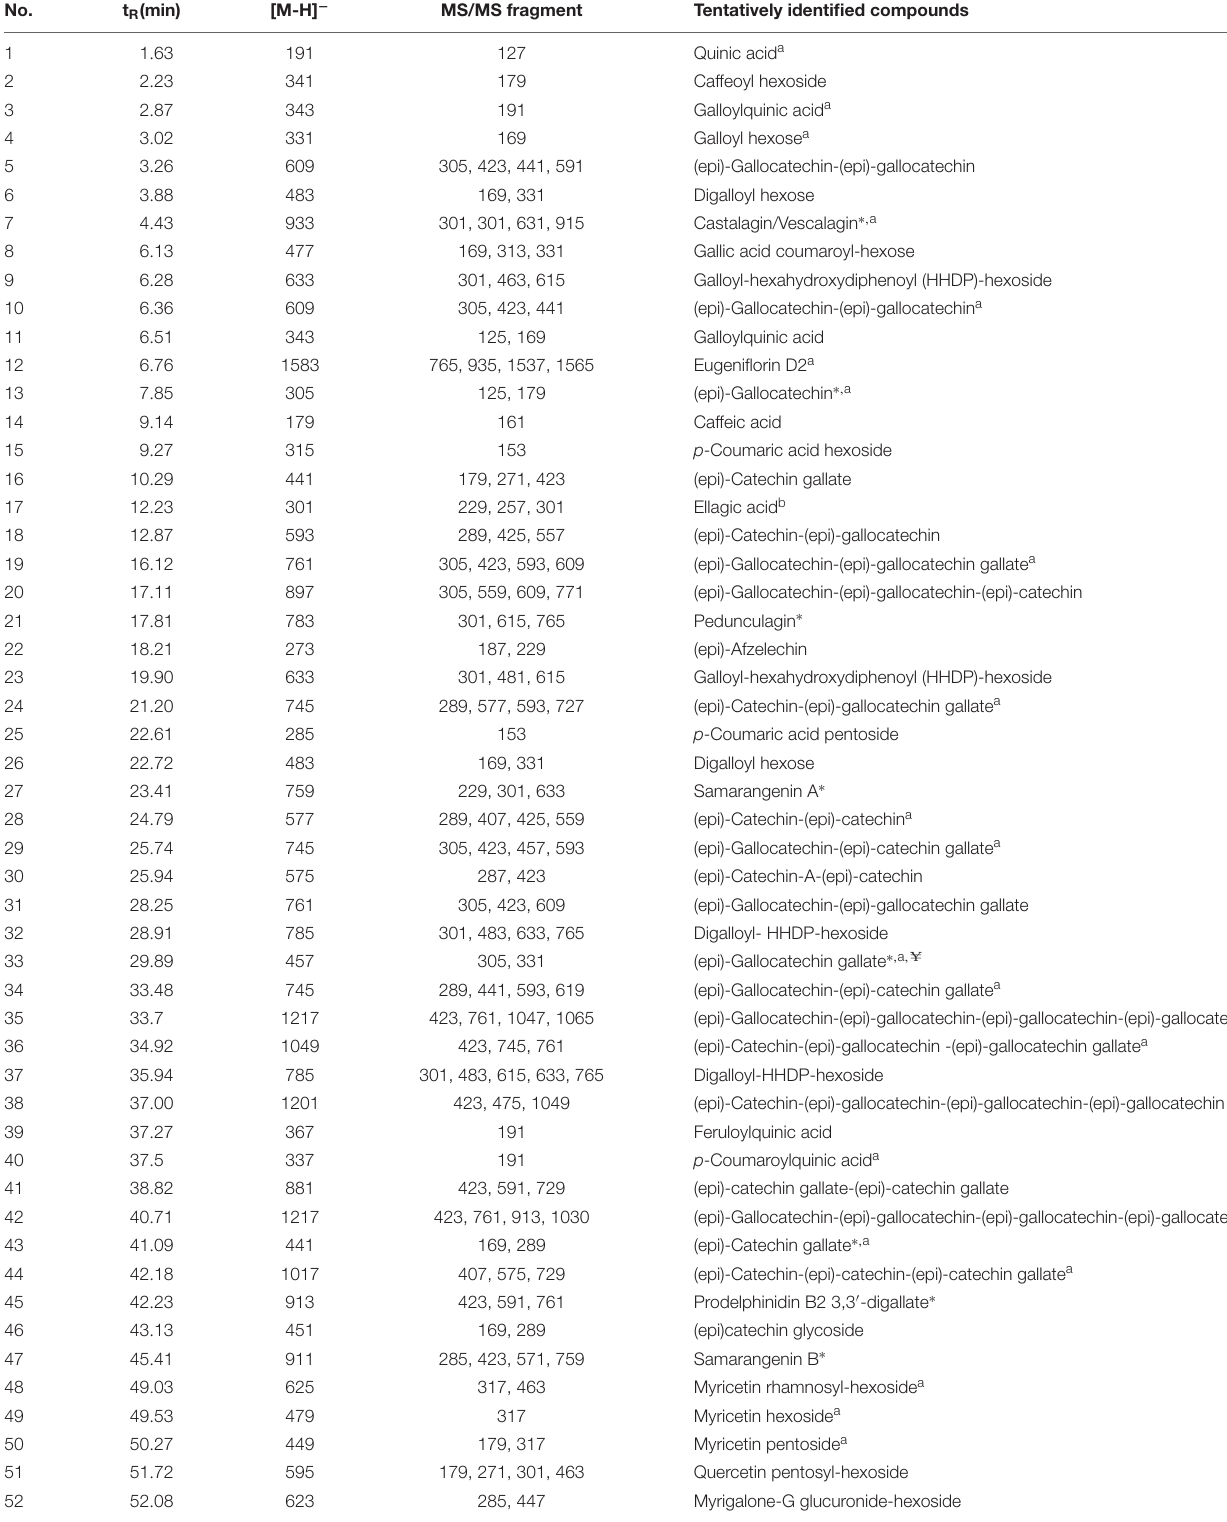
TABLE 1 | Secondary metabolites from a methanol extract of S. aqueum leaves by HR-LC-MS/MS.